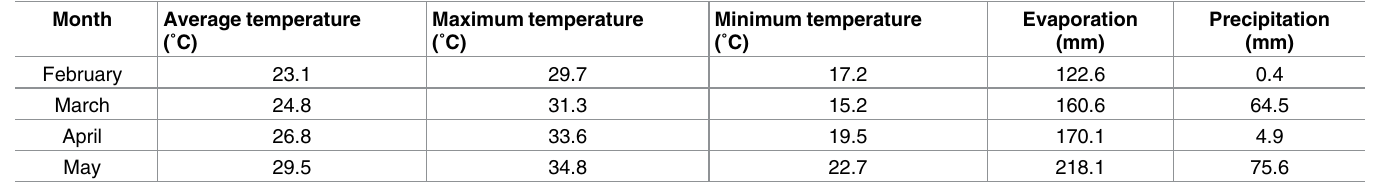
Table 1. Temperature (T), Evaporation (E) and Precipitation (P) from February to